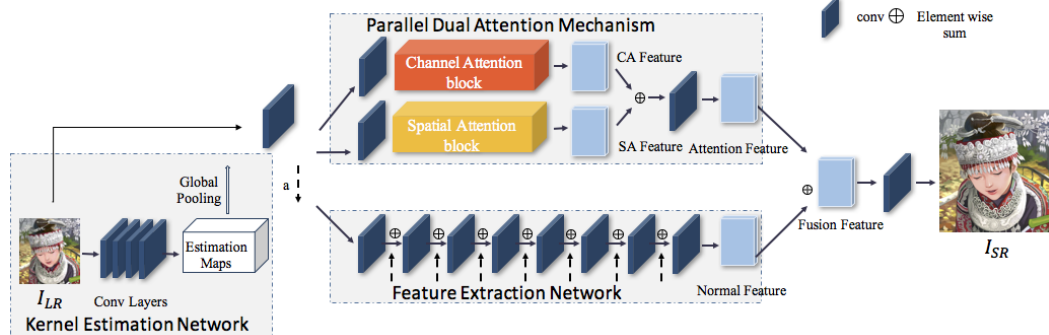
Figure 2. The structure of our proposed